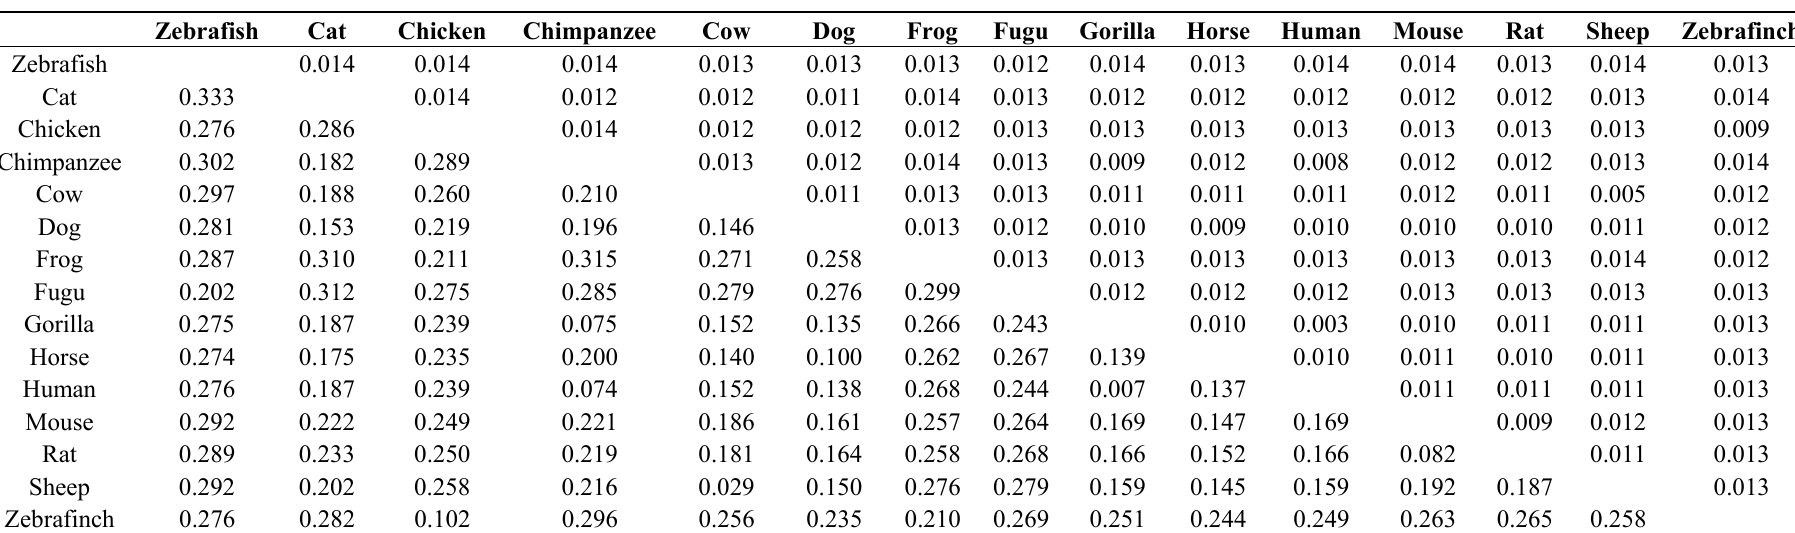
Table 4. Estimates of MTNR1B evolutionary divergence (below diagonal) and standard errors (above diagonal) between sequences. Zebrafish Cat Chicken Chimpanzee Horse Human Sheep